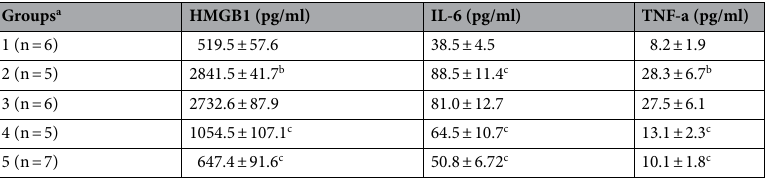
Table 1. Serum level of HMGB1, IL-6 and TNF-α was detected by ELISA in five different groups (M ± S). Mean ± standard deviation. a Group 1, controls; group 2, ARS group without treatments; Group 3, ARS rats treated by normal saline; Group 4, ARS rats were daily treated by 10 ul ethyl pyrovate, twice a day. Group 5, treated by 20ul ethyl pyrovate, twice a day. b p < 0.001 when compared with group 1. c p < 0.05 compared with group